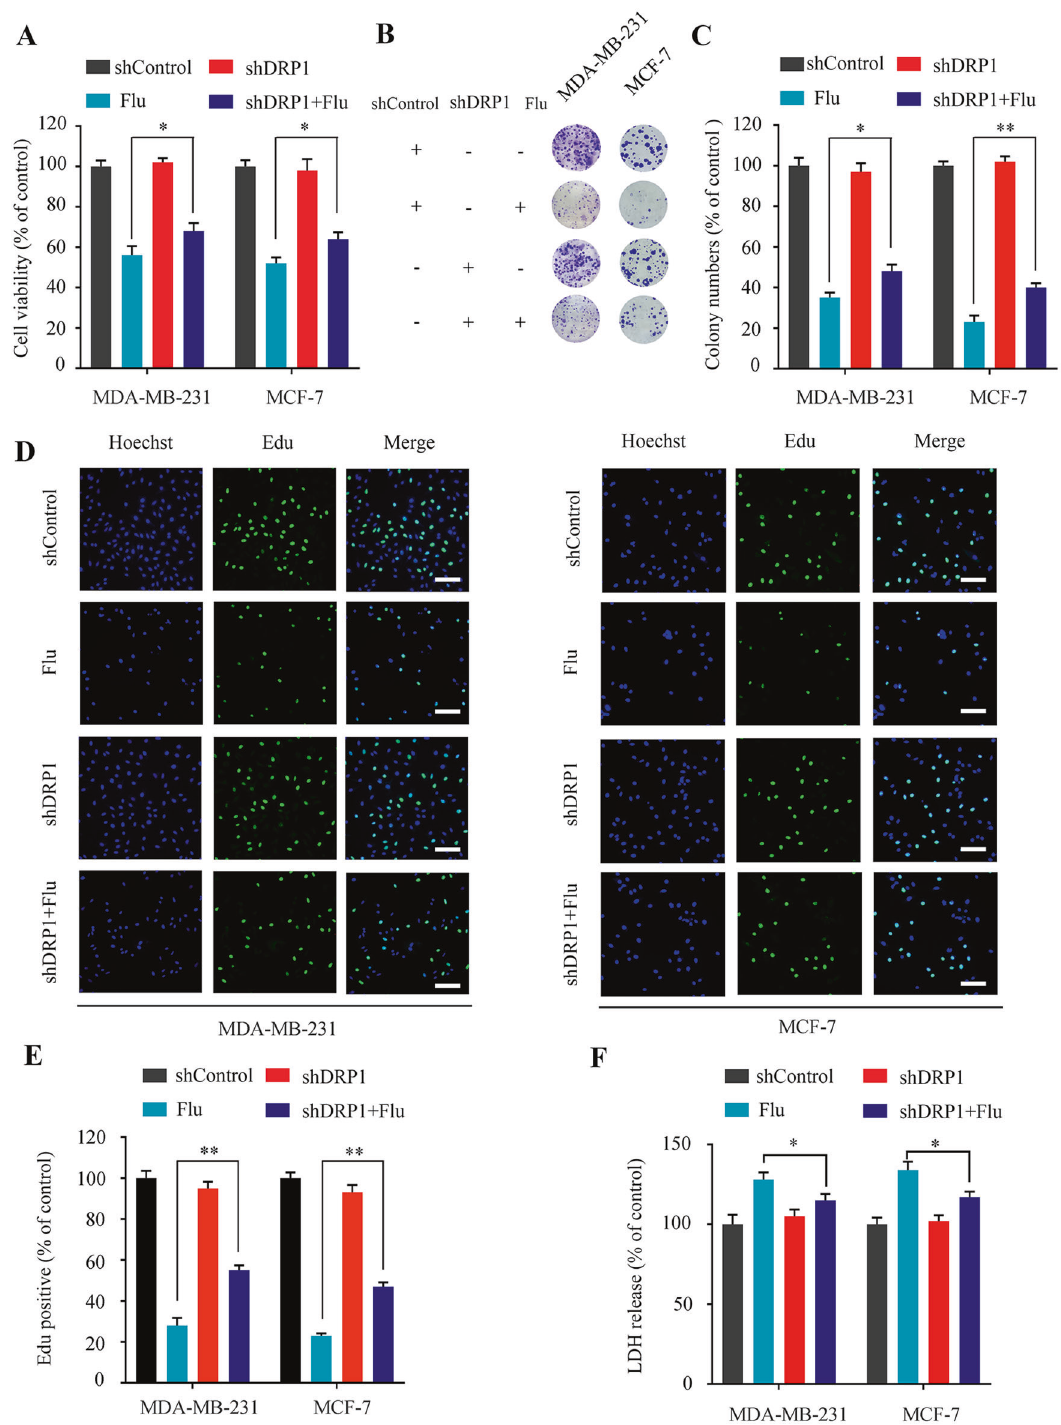
Fig. 4 Flubendazole-induced mitophagy inhibits cell proliferation in fl ubendazole-treated MDA-MB-231 and MCF-7 cells. A MDA-MB-231 and MCF-7 cells were transfected with negative-control or DRP1 shRNA for 24 h, respectively. After treatment with or without fl ubendazole (0.5 μ M) for 24 h, cell viability was measured by MTT assay. B , C MDA-MB-231 and MCF-7 cells were transfected with negative-control or DRP1 shRNA for 24 h, respectively. After treatment with or without fl ubendazole (0.5 μ M) for two weeks. Representative images and quanti fi cation of colonies were shown. D – F MDA-MB-231 and MCF-7 cells were transfected with negative-control or DRP1 shRNA for 24 h, respectively. After treatment with or without fl ubendazole (0.5 μ M) for 24 h, then detected by Edu assay ( D , E ) and LDH release ( F ). Scale bar, 50 µm. Data represent mean ± SD. * P < 0.05, ** P < 0.01, *** P < 0.001. Statistical signi fi cance compared with respective control groups (all P -values were obtained by one-way ANOVA).